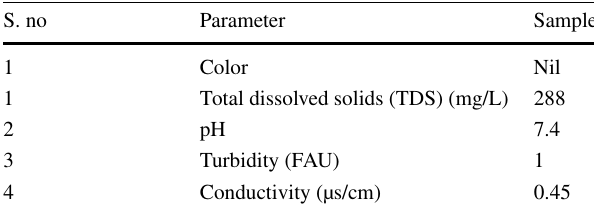
Table 1 Detailed characteristics of feed raw water